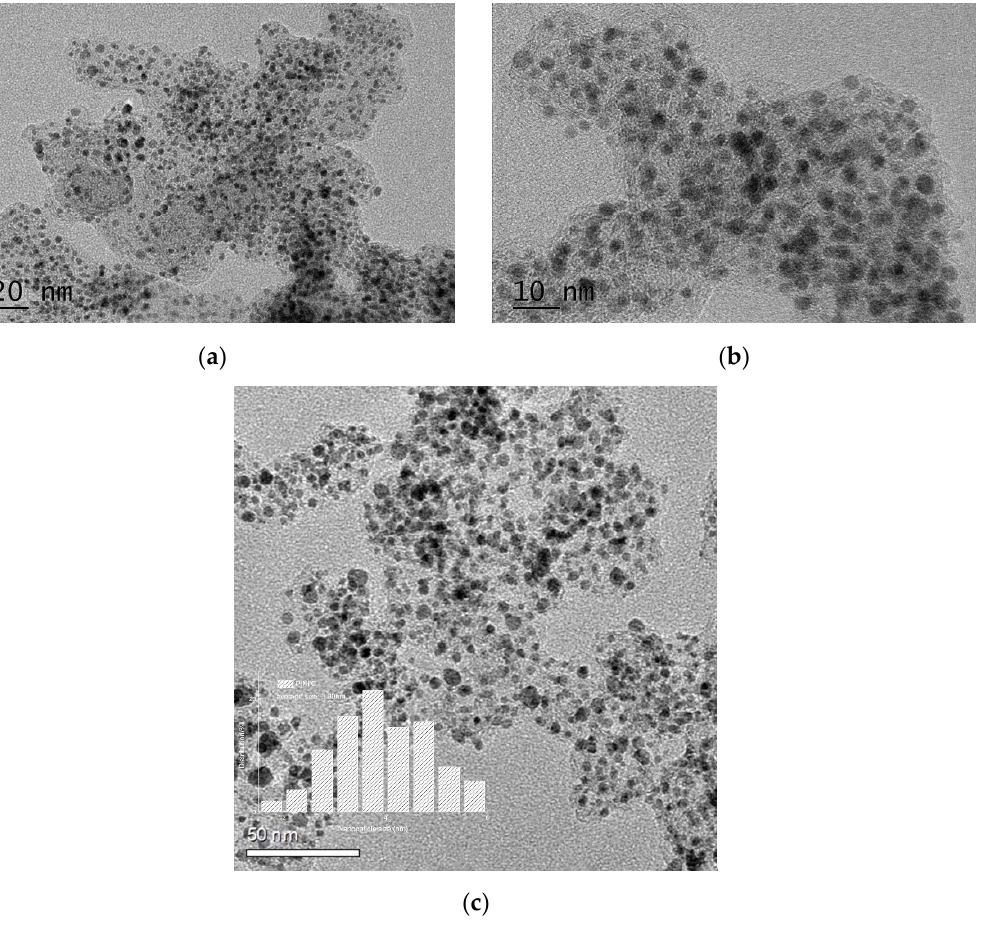
Figure 3. TEM images of PtNi/C. ( a – c ) are the TEM images of PtNi/C at different magnification.